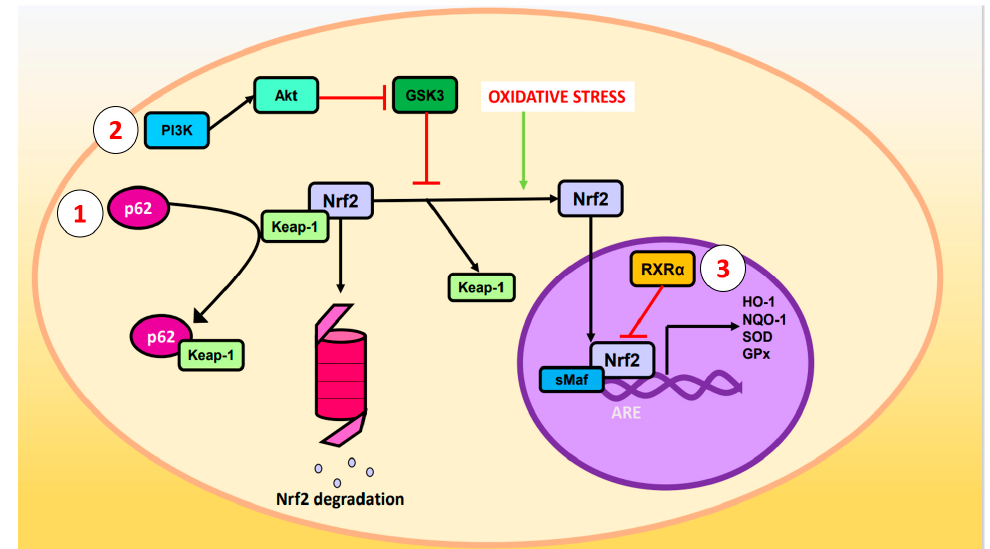
Figure 1. Regulation of Nrf2. Oxidative stress causes cleavage of Nrf2 and Keap-1 such that Nrf2 ceases to be degraded in the proteasome and enters the nucleus where it forms a heterodimer with sMaf and induces the expression of ARE genes such as HO-1, NQO-1, SOD, and GPx. The Nrf2 pathway can be modulated by the (1) p62, (2) PI3K/Akt/GSK-3, or (3) RXR α pathways.